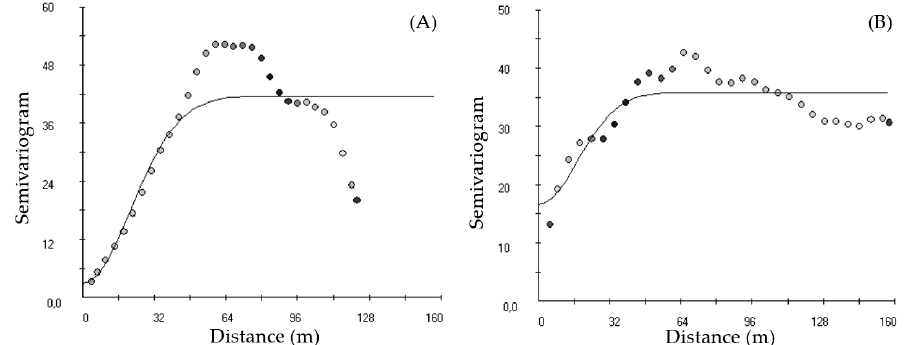
Figure A1. Semivariogram of the Thiessen areas of the spatial distribution of cattle dung, for the different ICLS: ( A ) crop–livestock, CL and ( B ) crop–livestock–tree CLT, considering all evaluations.